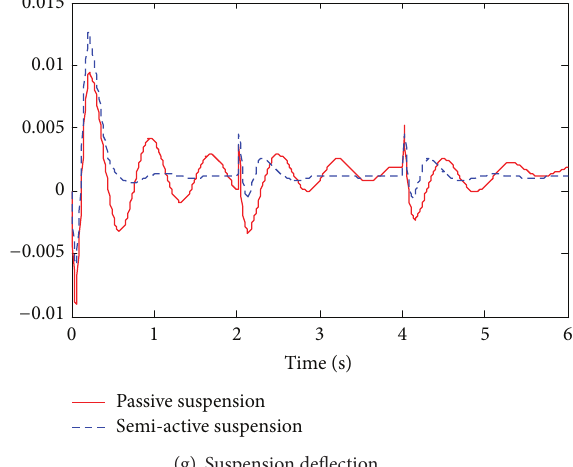
Figure 6: Suspension system to the second